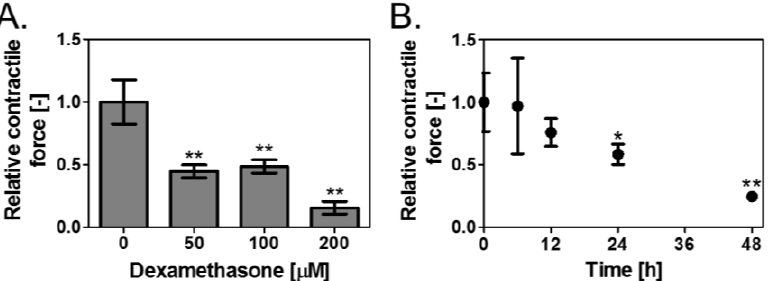
Figure 3. Loss of contractile force of skeletal muscle tissues by treatment with Dex. ( A ) Effects of Dex concentration (0, 50, 100, and 200 µM) on contractile force of the skeletal muscle tissues cultured in DM for 6 d. The tissues were treated with Dex for 48 h. Results represent mean ± SD ( n = 3). ** p < 0.01 versus 0 µM; ( B ) Effects of Dex treatment duration (0, 6, 12, 24, and 48 h) on contractile force of the skeletal muscle tissues cultured in DM for 6 d. Dex was added at 100 µM. Results represent mean ± SD ( n = 3). * p < 0.05 versus 0 h. ** p < 0.01 versus 0 h.